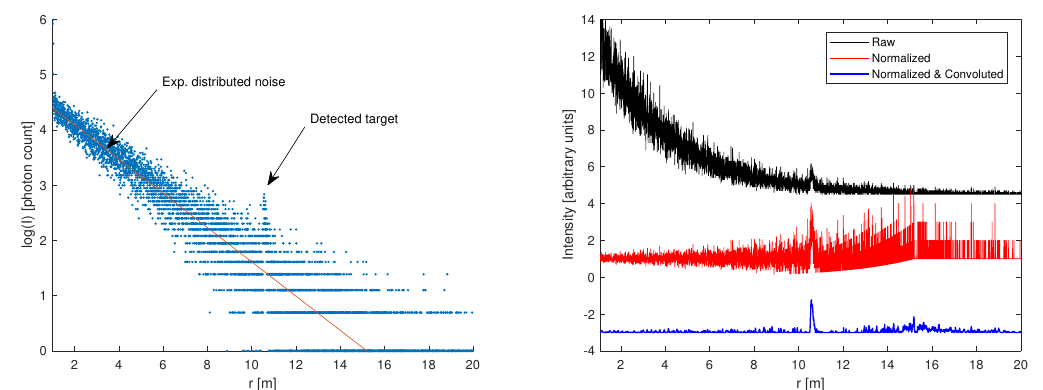
Figure 2. Traditional signal processing for range detection. (a) Exponential noise distribution f N is visible from a channel detecting a target not illuminated by direct sunlight. The target can be detected only after sampling (and processing) the signal (here: the sample size is 100 000). The line is from an exponential function and it is drawn to guide the eye. (b) Processing of the raw signal by normalizing with respect to the exponential noise distribution f N and by convolution (here: 3 . 81 cm wide uniform kernel). The estimated (red) signal peak area to the total (black) area is 0 . 18%